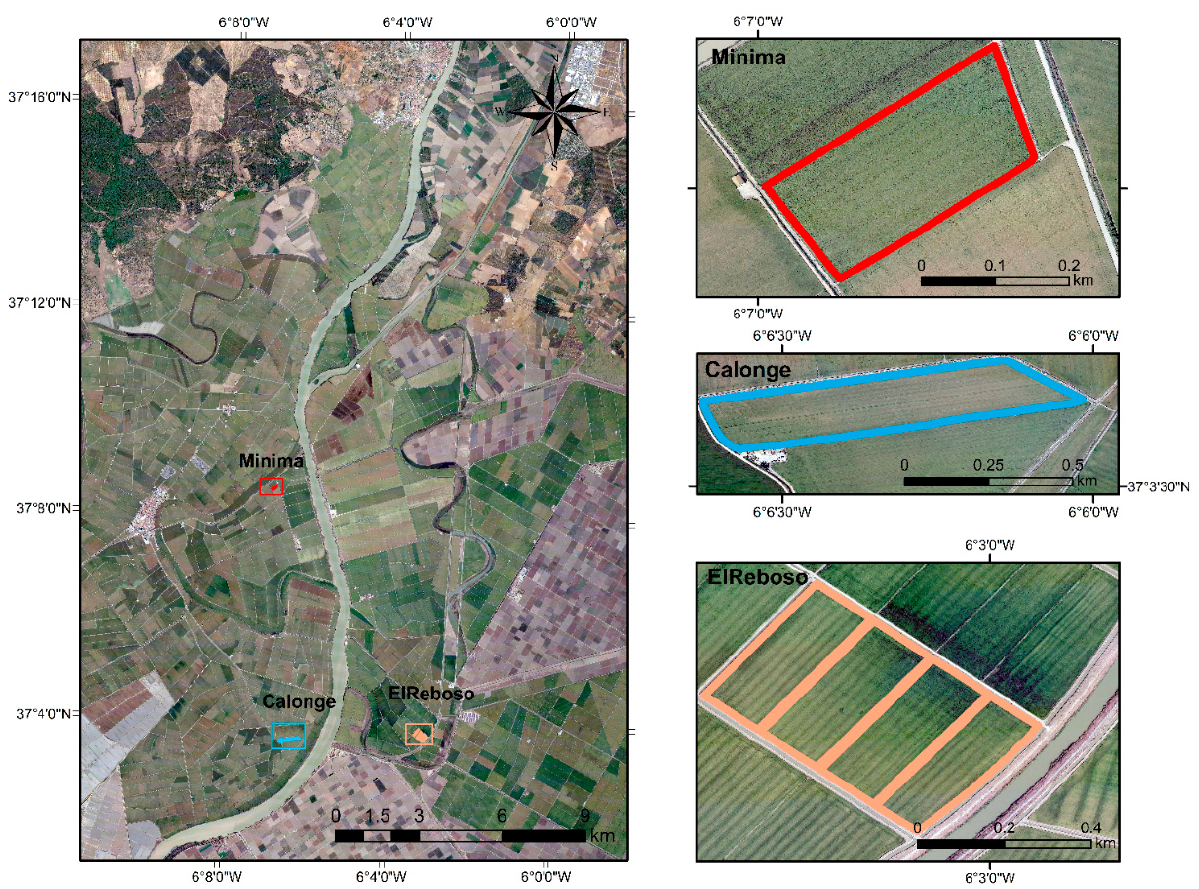
Figure 1. The location of the test site in Seville, Spain is on the left. The locations of the ground campaign plots are highlighted and magnified on the right.